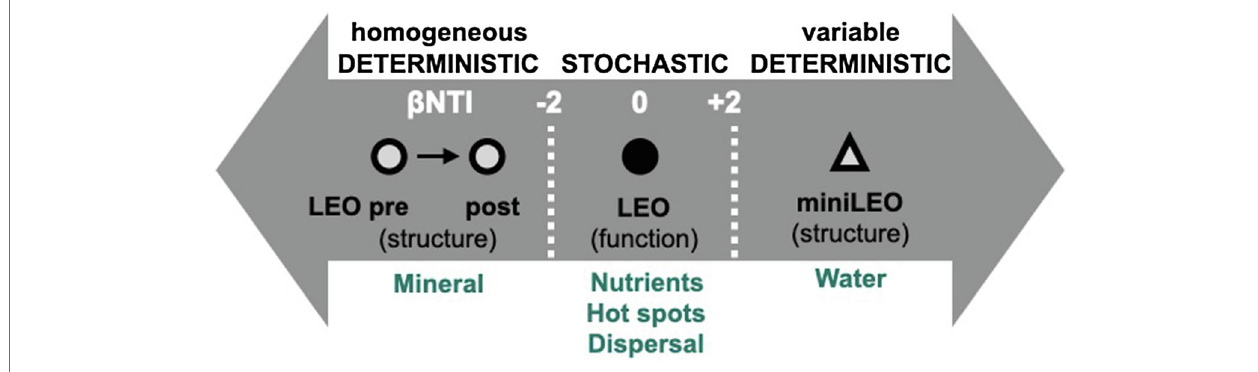
FIGURE 8 | Conceptual depiction of microorganism assembly in an incipient system. Deterministic assembly processes select for structural composition, while stochastic processes driven by local environmental features shape functional